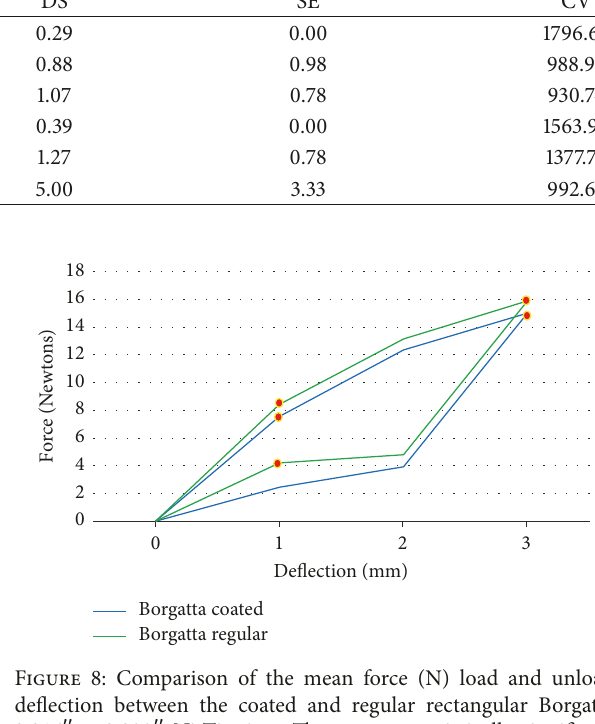
Figure6:Comparisonofmeanforce(N)loadandunloaddeflection between the coated and regular rectangular TP Ni-Ti 0.016 󸀠󸀠 × 0.022 󸀠󸀠 Ni-Ti wires. There was a statistically significant increase in the coated Ni-Ti wires at 1 mm ( 𝑝 < 0.01 ) and a decrease at 3 mm ( 𝑝 < 0.01 ) load deflection compared with the regular Ni-Ti wire. There was no statistically significant difference in unload deflection.